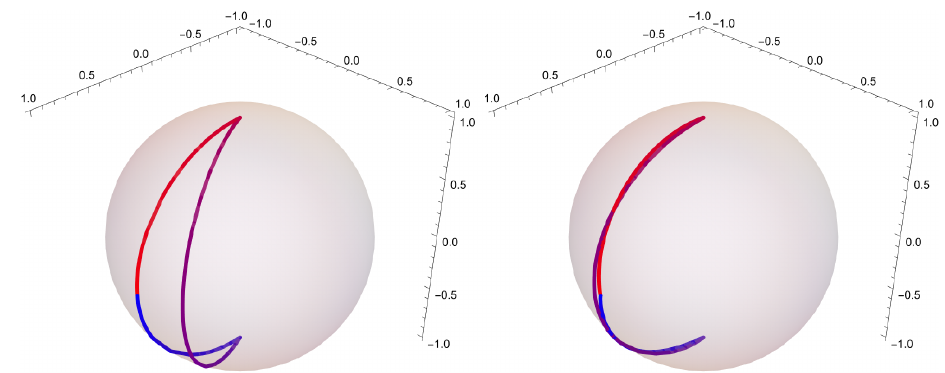
FIG. 2. An illustration of a dynamical invariant eigenvector’s evolution along the Bloch sphere for the geometric X π/ 2 gate (left) and the dynamical X π/ 2 gate (right). The path is traversed twice and its orientation is determined by the color gradient that begins with red and ends with blue. We see that | φ + ( t ) (cid:2) traces out a loop with nonzero area in the geometric case. In contrast, the loop in the dynamical case encloses zero area.